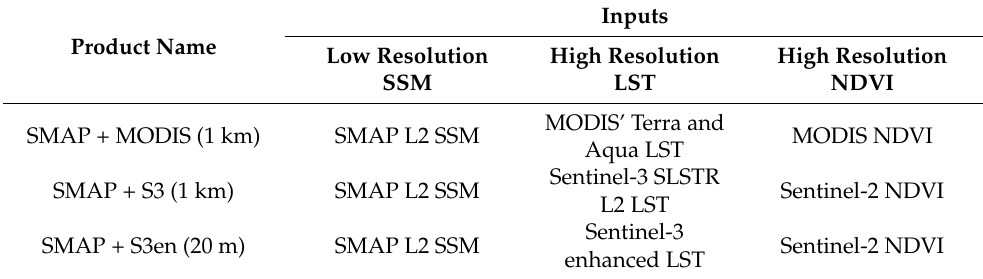
Table 1. Presentation of the different products produced using the DisPATCh